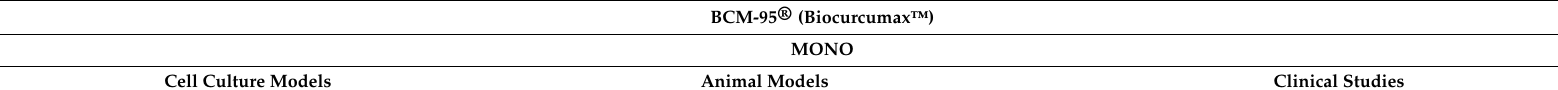
Table 1. E ff ects of BCM-95 ® (Biocurcumax ™ ) obtained in vitro, in vivo and in clinical